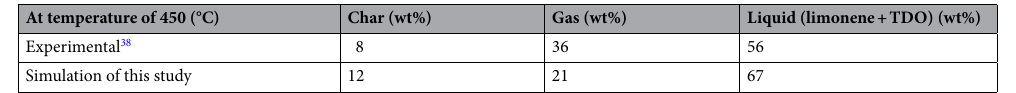
Table 5. Simulated and experimental results at 450 °C and heating rate of 10 C min −1 .